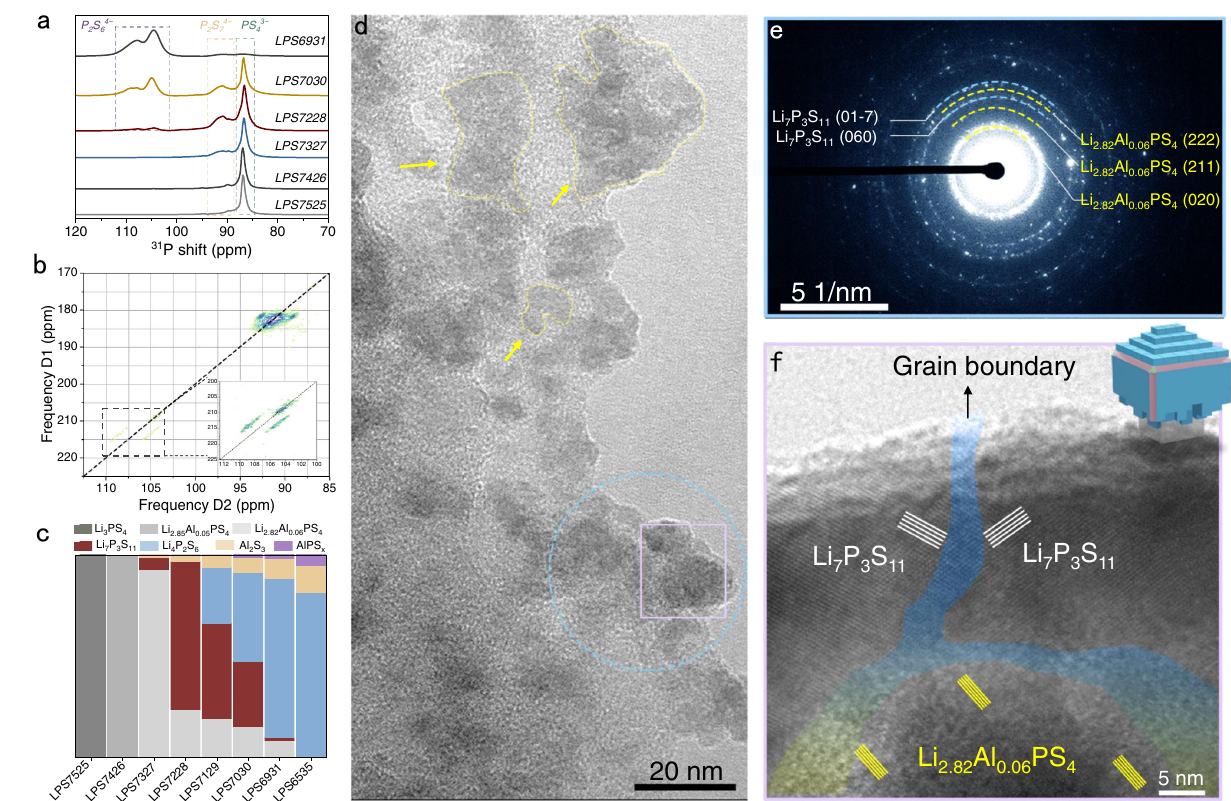
Fig. 2 | Speci fi c species of Al-GCs and the microstructure of hetero- nanodomains. a 31 P MAS SSNMR spectra of Al-GCs. b 2D 31 P refocused INADE- QUATE spectrum of LPS7228. The contour peaks in the 2D spectrum indicate the